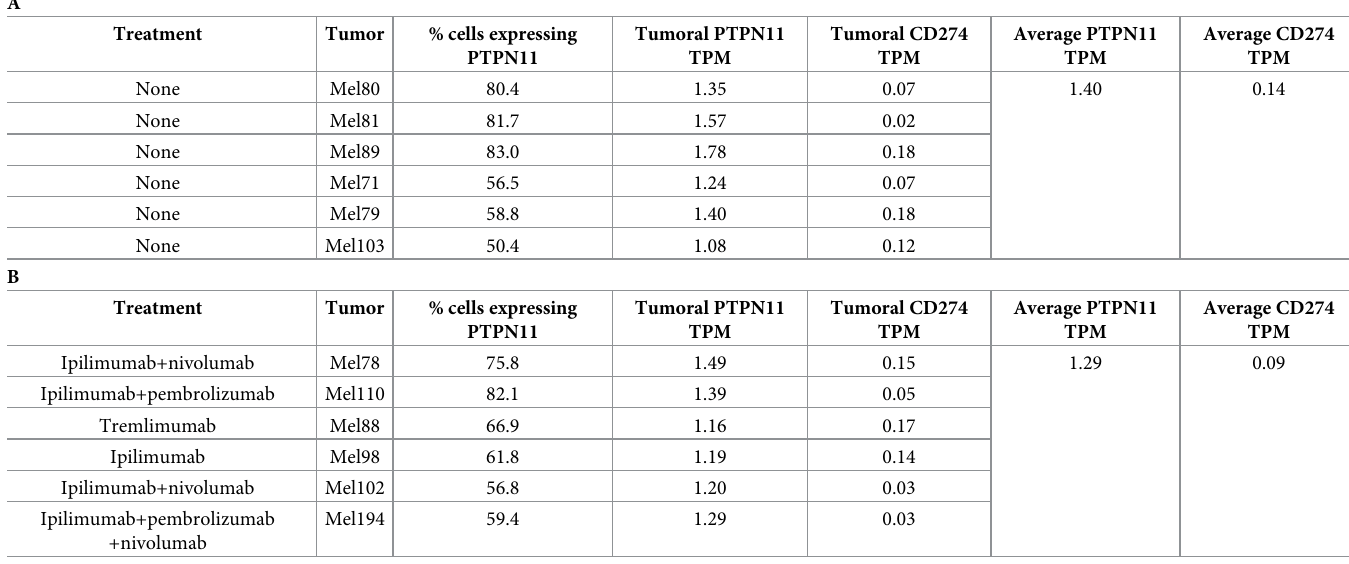
Table 1. A. PTPN11 mRNA expression weakly associated with reduced CD274 mRNA expression in melanoma tumors regardless of ICI exposure. B. PTPN11 mRNA expression weakly associated with reduced CD274 mRNA expression in melanoma tumors regardless of ICI